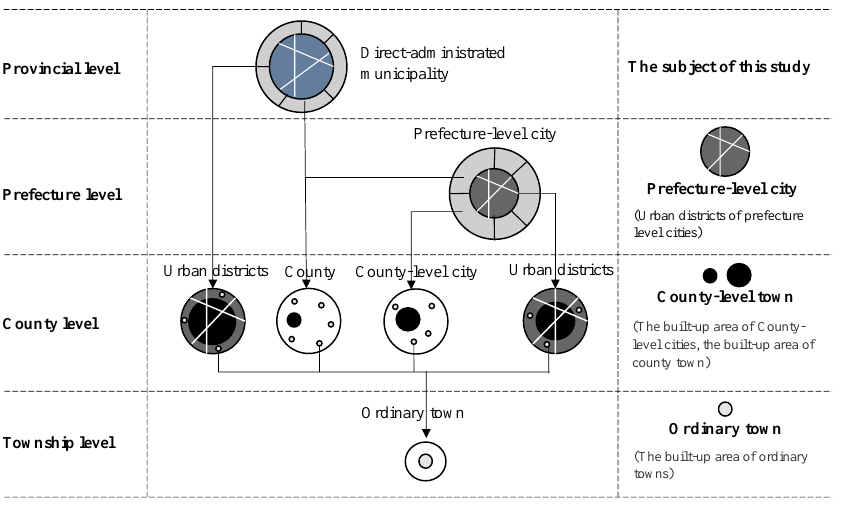
Figure 1. A multi-level perspective of Chinese cities and towns (revised from Li and Mykhnenko [50]).